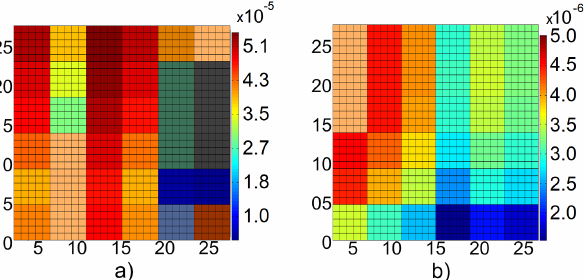
Figure 26. Visualization of a subarea’s conductivities in Leptosol’s profile. ( a ) First layer and ( b ) second layer.